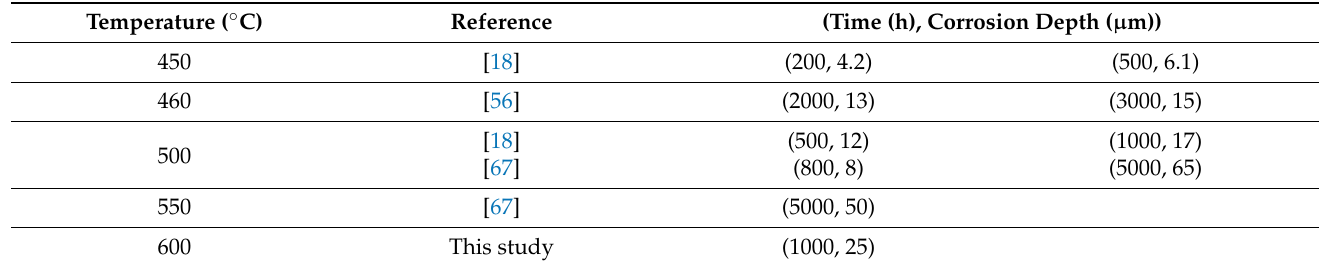
Table A2. Data points plotted in Figure 16 [18,56,67].